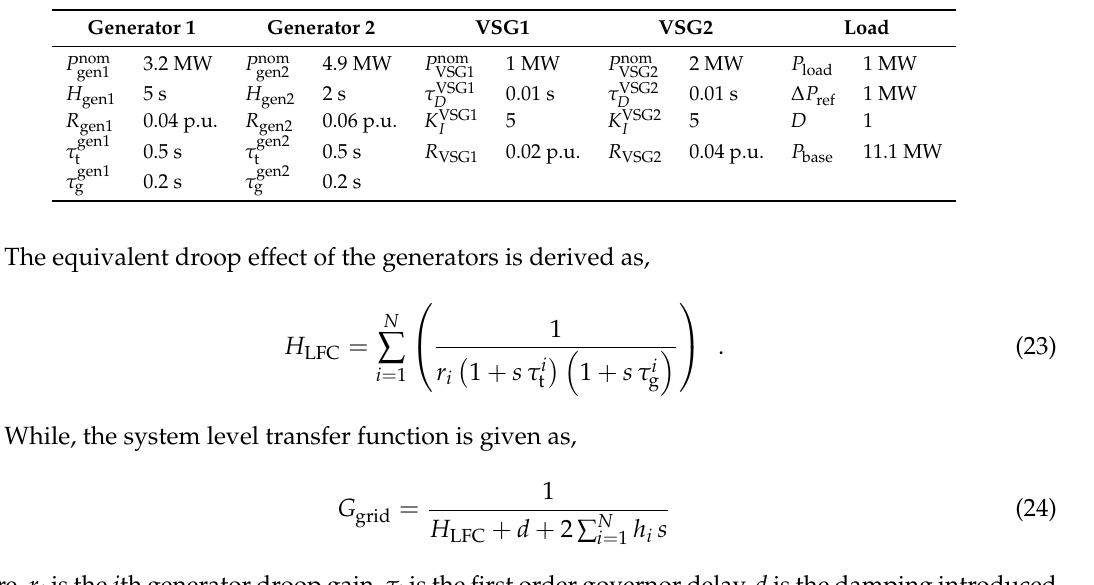
Figure 11. Single line diagram of the multi-machine system. Table 3. Parameters for multi-machine